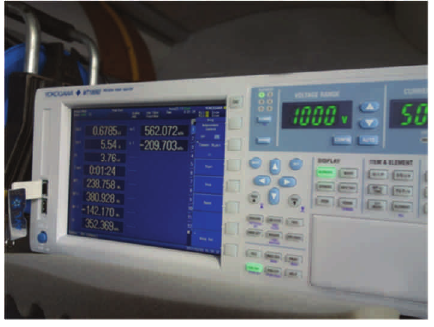
Fig. 6. Yokogawa WT 1800E Power